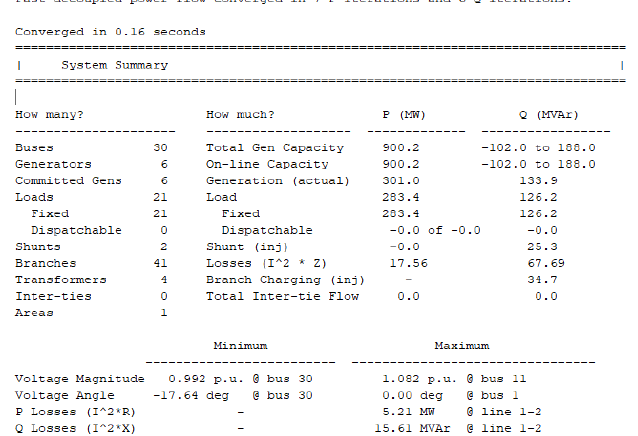
Figure 3. System summary and load flow analysis using Fast decoupled load flow method